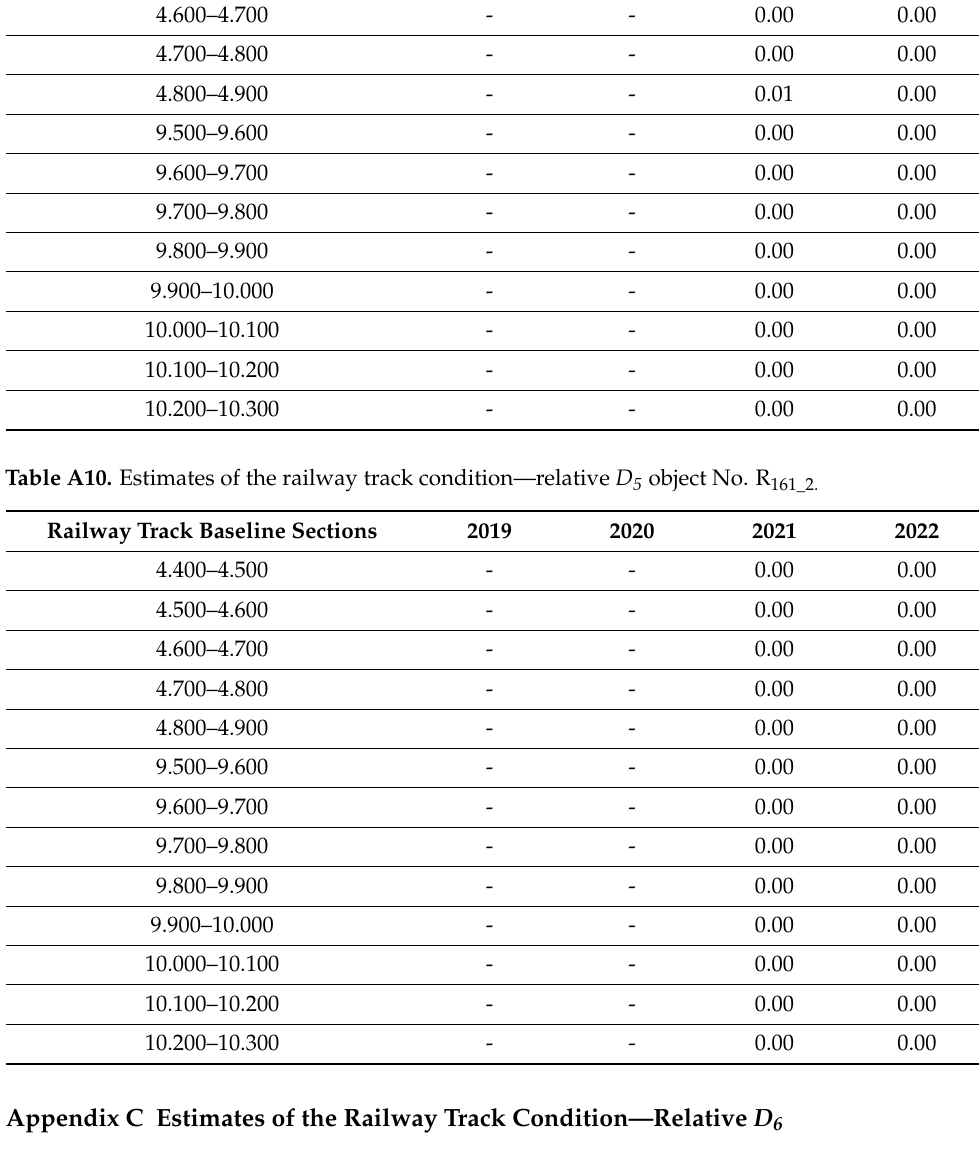
Table A11. Estimates of the railway track condition—relative D 6 , object Nos. R 143_1_1 and R 143_1_2. Railway Track Baseline